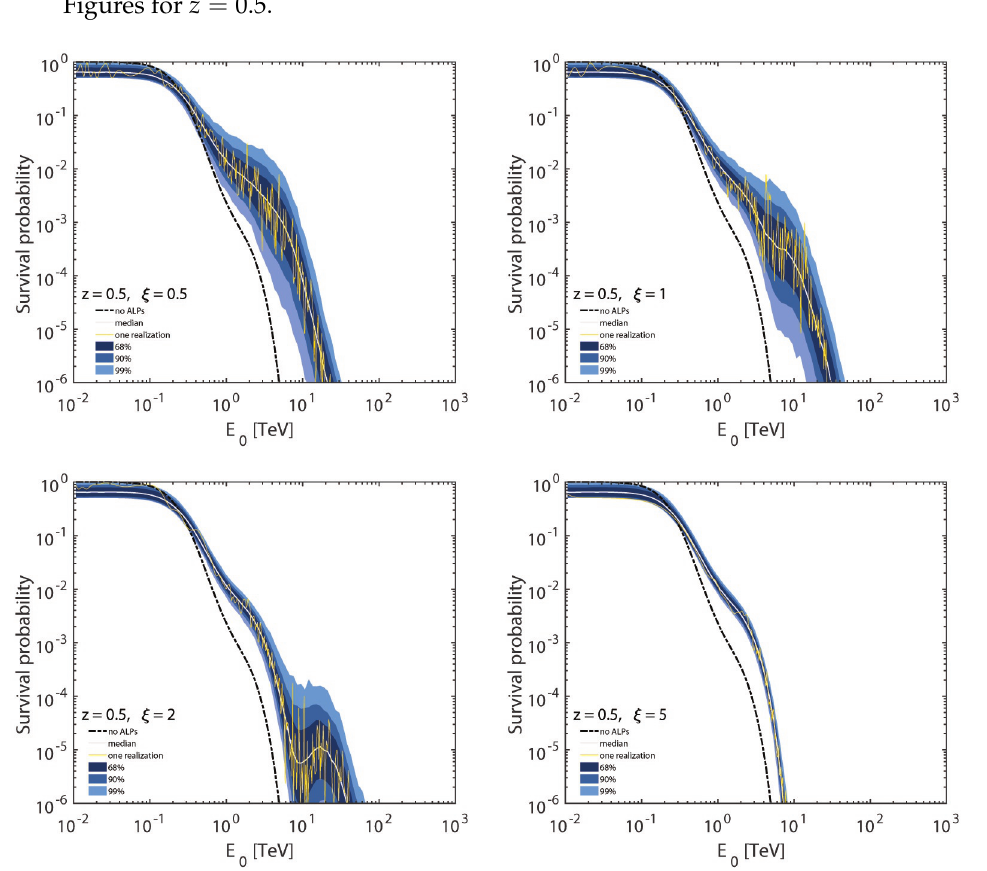
Figure 21. Same as Figure 17 apart from z = 0.5. (Credit [115]). Figures for z = 1.